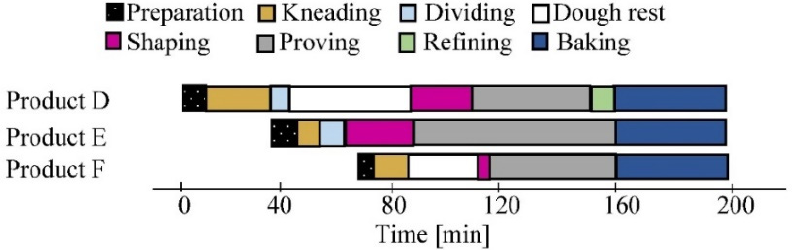
Figure 4. A schedule for one simplified group of products baked in one oven compartment at the same